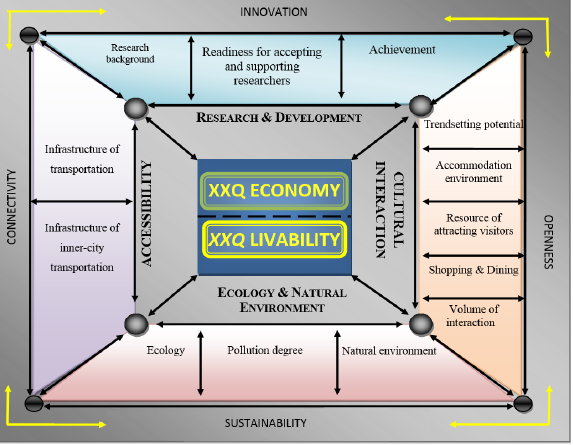
Figure 1: The ‘ urban piazza ’ for the performance structure of large